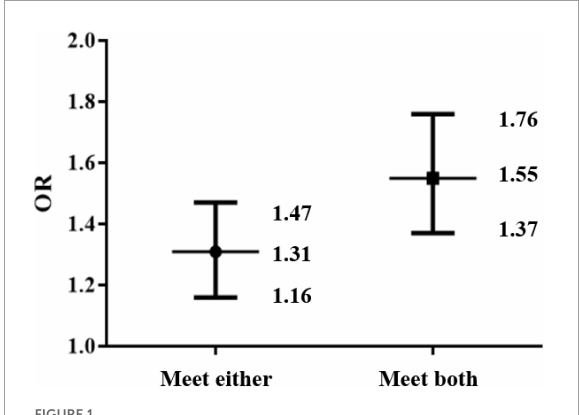
FIGURE1 The associations between physical activity and screen time guidelines (in insolation or combination) and life